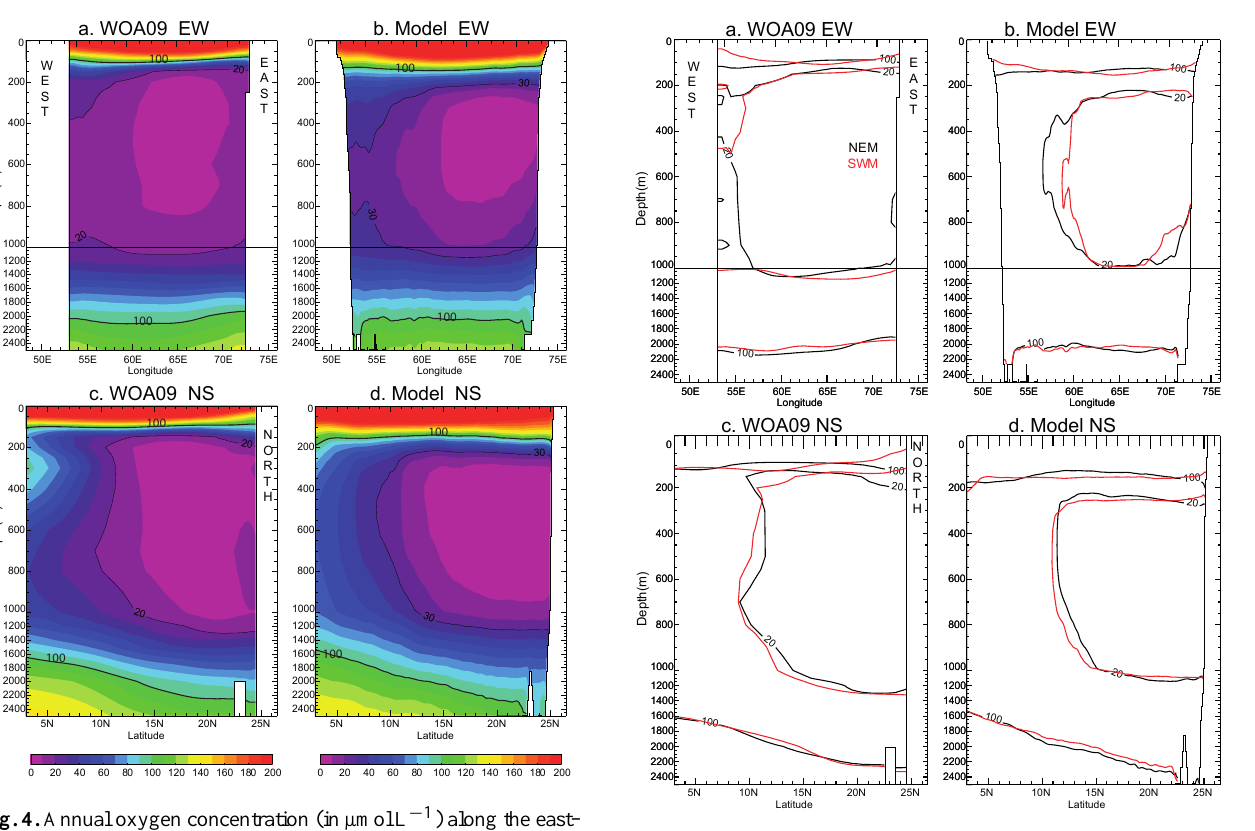
of the OMZ it is ≤ 5 % (amplitude of annual variations of ∼ 1–3 µmol L − 1 compared to an annual-mean oxygen